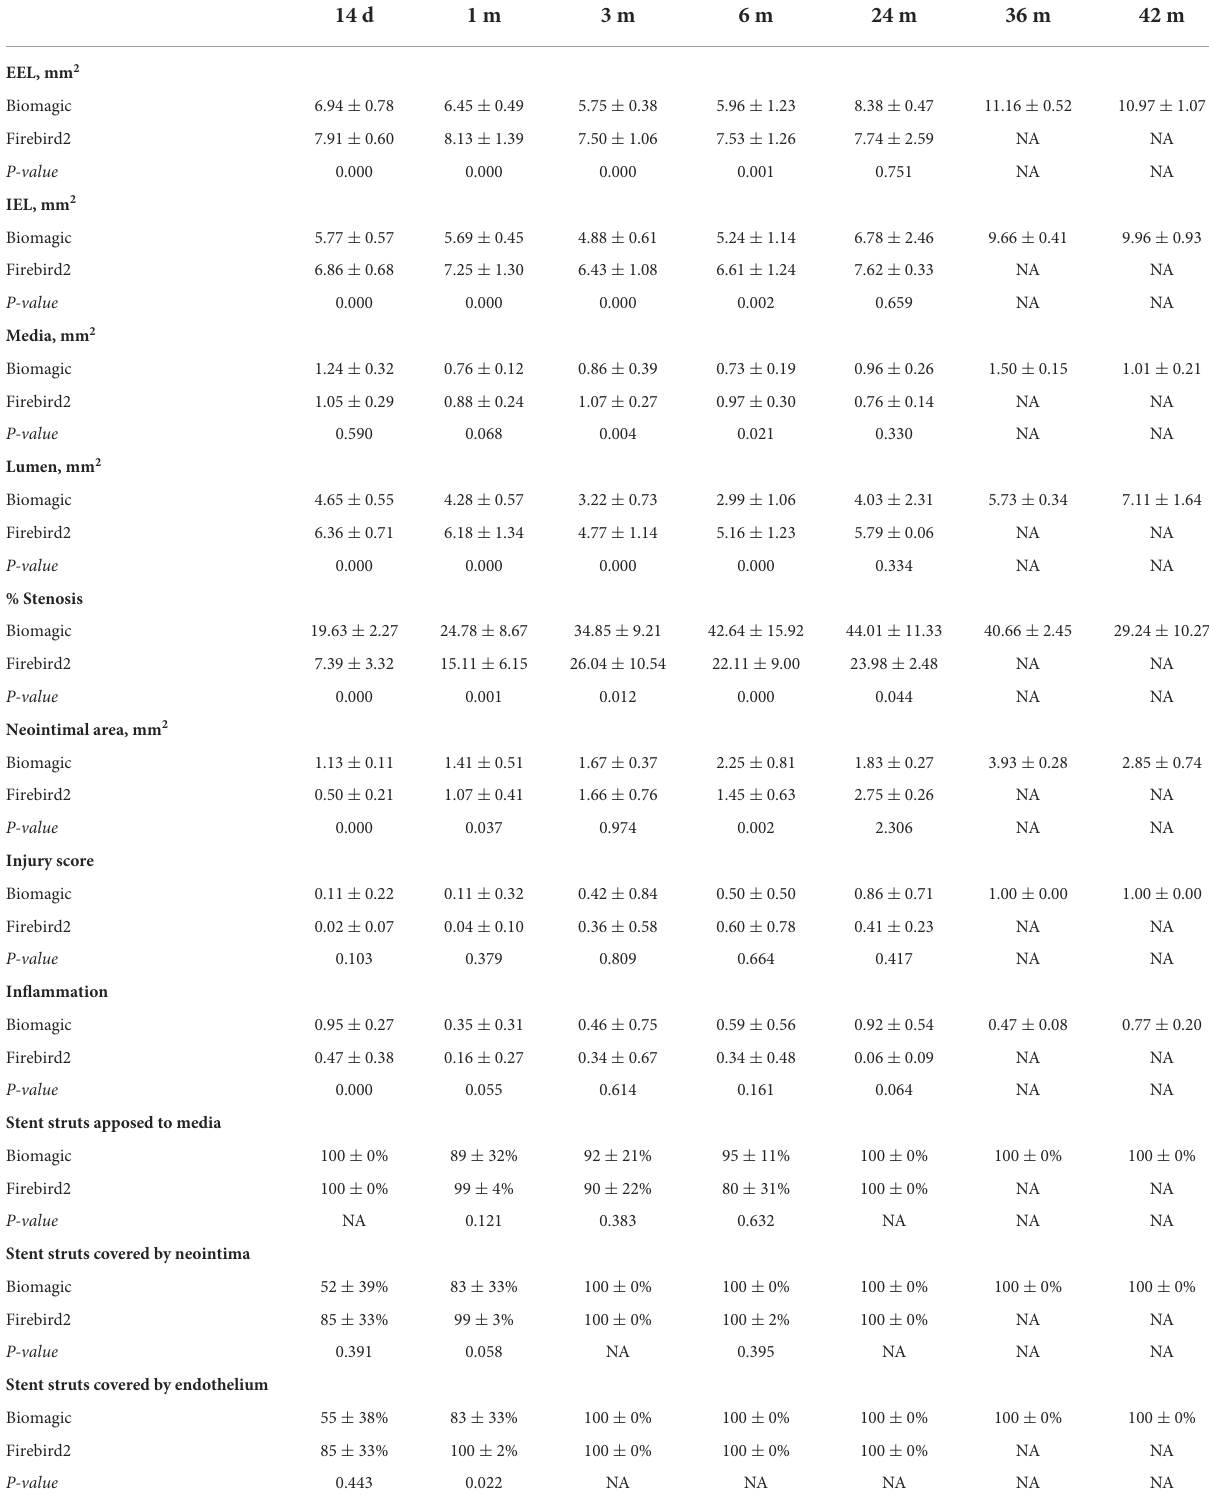
TABLE 3 Histological